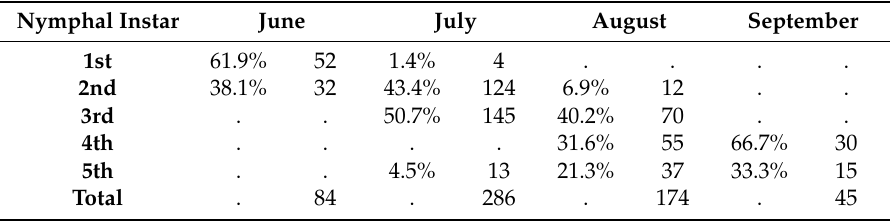
Table 5. The percentage and number of individuals per nymphal instar collected each month in 2015. Nymphal Instar June July August September 1st 61.9% 52 1.4% 4 . . . . 2nd 38.1% 32 43.4% 124 6.9% 12 . . 3rd . . 50.7% 145 40.2% 70 . . 4th . . . . 31.6% 55 66.7% 30 5th . . 4.5% 13 21.3% 37 33.3% 15 Total . 84 . 286 . 174 . 45